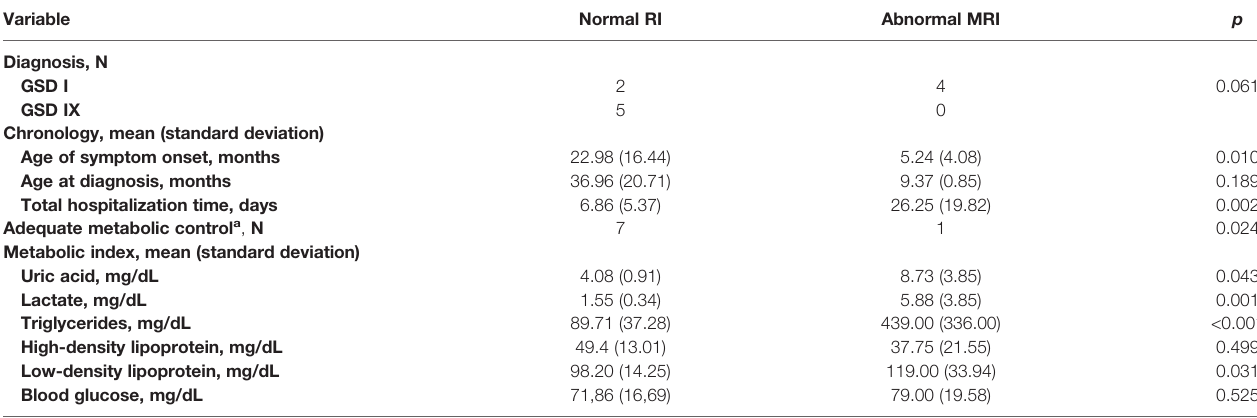
TABLE 4 | Magnetic resonance imaging (MRI) alterations relative to diagnosis, chronology variables, and metabolic